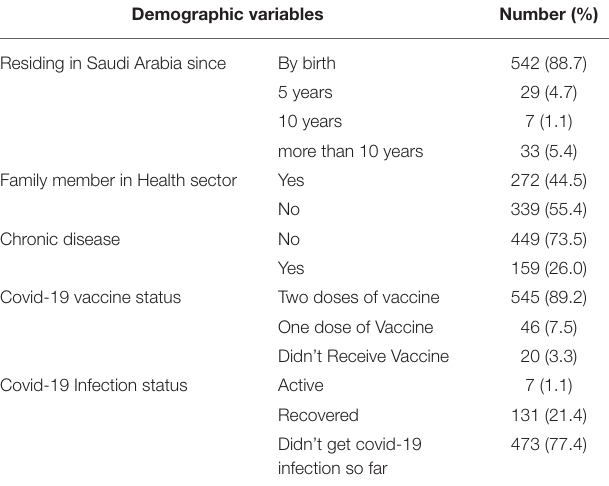
TABLE 2 | Self-medication pattern among residents of Riyadh, Saudi